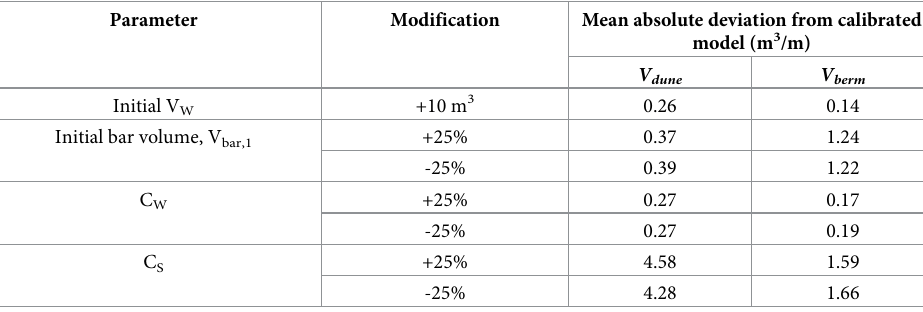
Table 2. Result from sensitivity analysis of calibrated